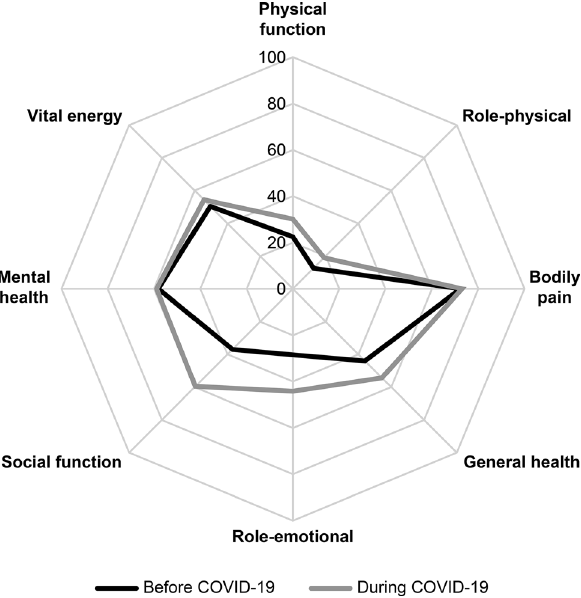
Figure 1. Comparison of stroke patients’ QOL before and during the COVID-19 pandemic. The overall PCS, MCS and the PF, RP, GH, RE, SF, VT sub-scores were significantly higher during the pandemic than those before the pandemic.